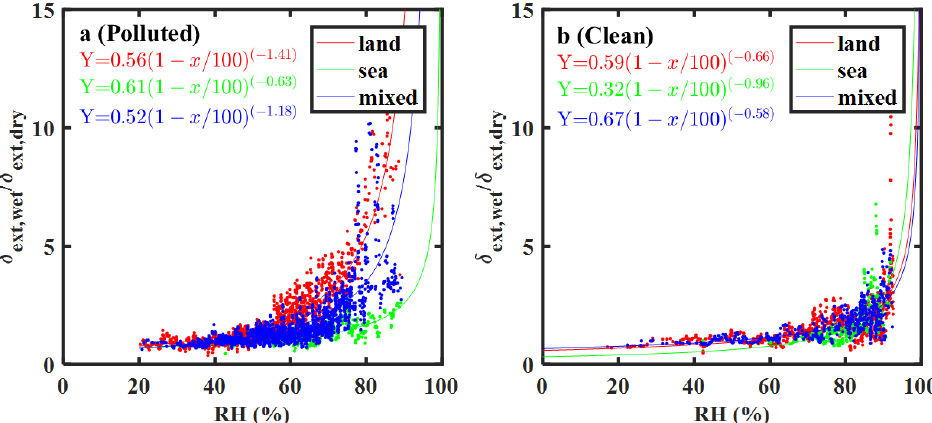
Figure 10. Aerosol from different sources under polluted and clean backgrounds in Qingdao from